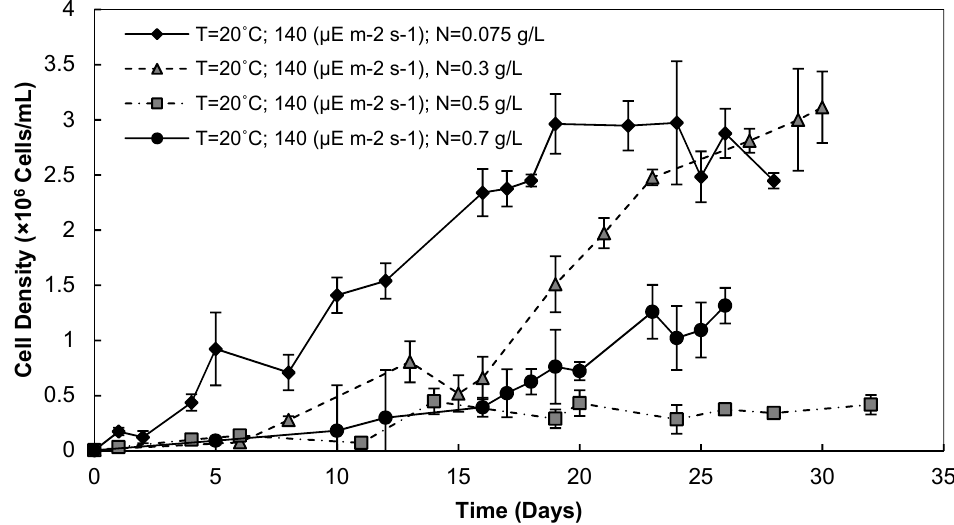
Figure 8. Cell density (×10 6 cell/mL) of P. cruentum at optimum temperature (20 °C) and light intensity (140 µE m − 2 s − 1 ) with different growth nutrient levels (0.075, 0.3, 0.5, or 0.7 g NaNO 3 /L).